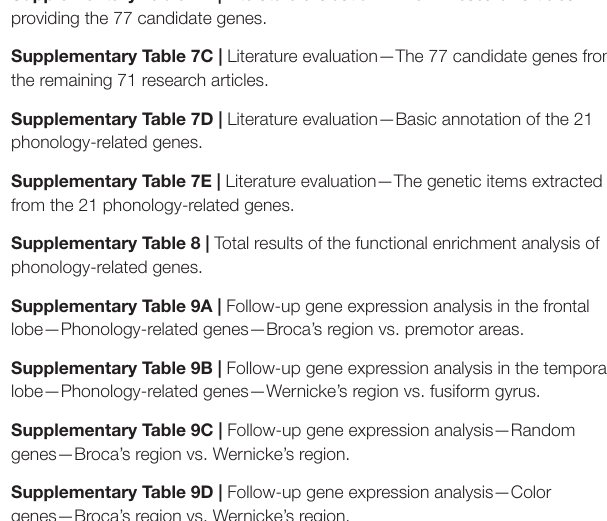
Supplementary Table 7A | Literature evaluation—The 36 excluded review